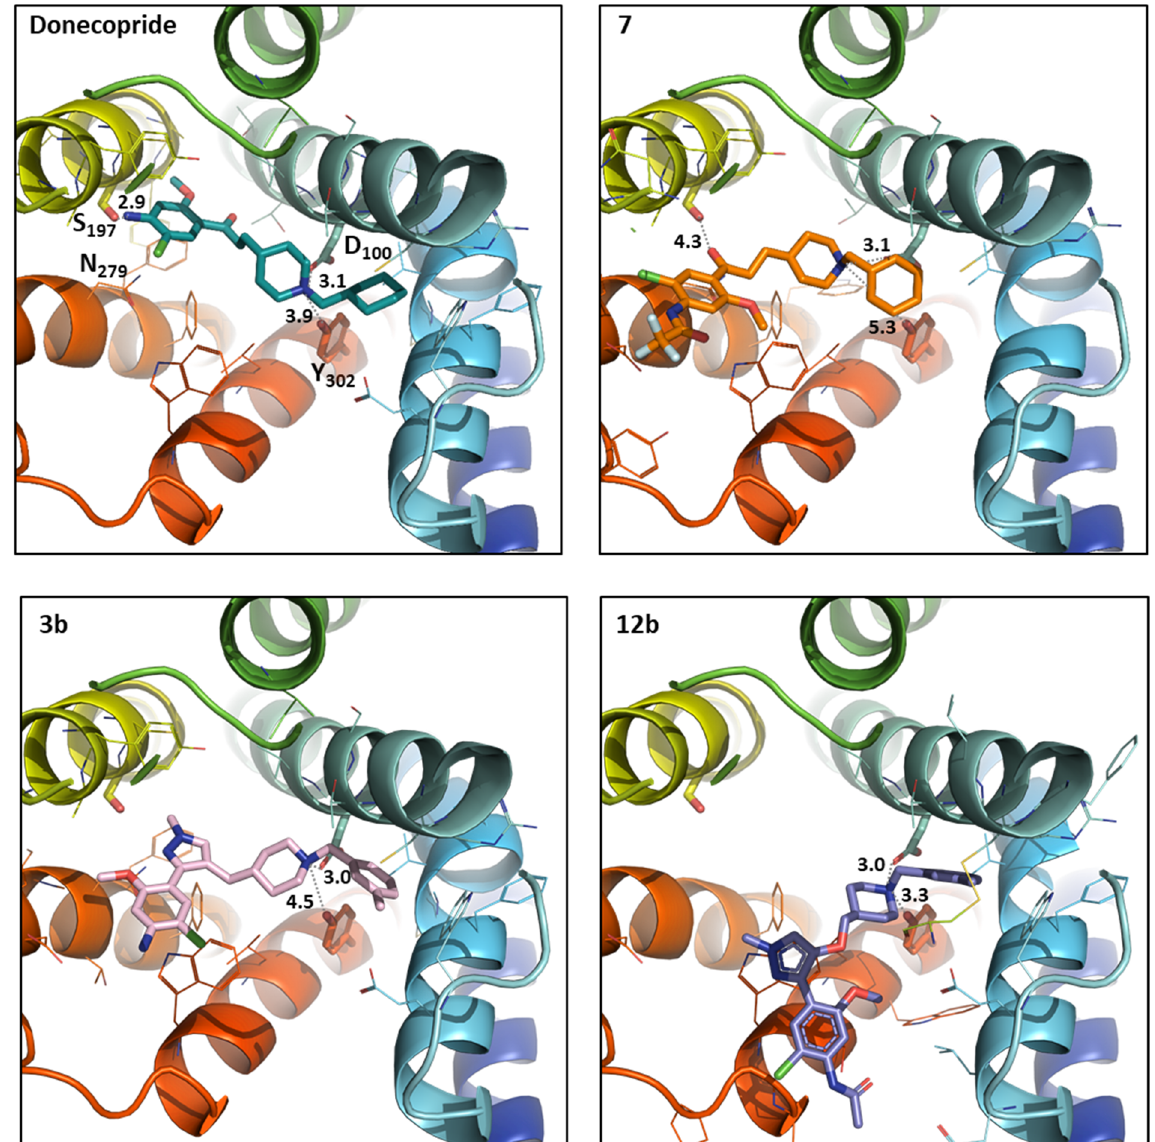
Figure 3. Donecopride (green) position compared to the compound 7 (orange), 3b (pink), and 12b (purple) positioned in h 5-HT 4 R binding sites using the docking studies. The compound and the selected side chains of the binding site residues are in stick and the protein in ribbon representation. This figure was made with PYMOL (DeLano Scientific, 2002, San Carlo, CA, USA) and the protein is presented in the same orientation in all four images.